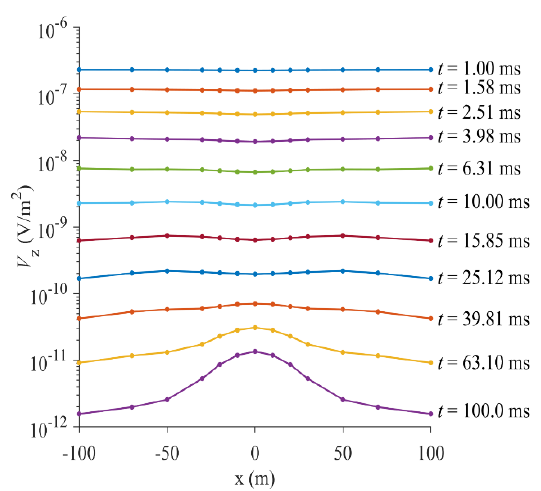
Figure 5. Profile map for the subsea tunnel model in the layered medium when the loop source height h 0 is 10 m.